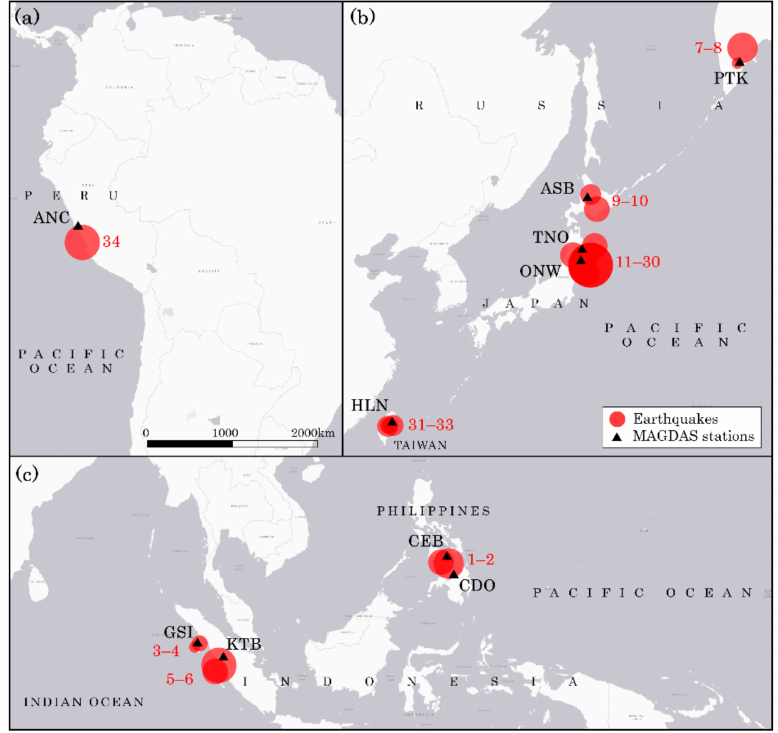
Figure 1. Maps of ( a ) South America, ( b ) East Asia, and ( c ) Southeast Asia. The circle radii are proportional to the magnitude of the earthquakes. The scale bar in ( a ) is relevant to the whole